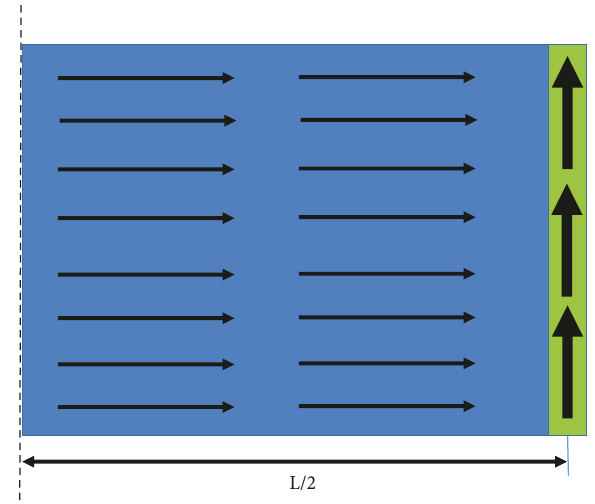
Figure 4: The schematic for 1-D mass transfer fl ow between matrix and